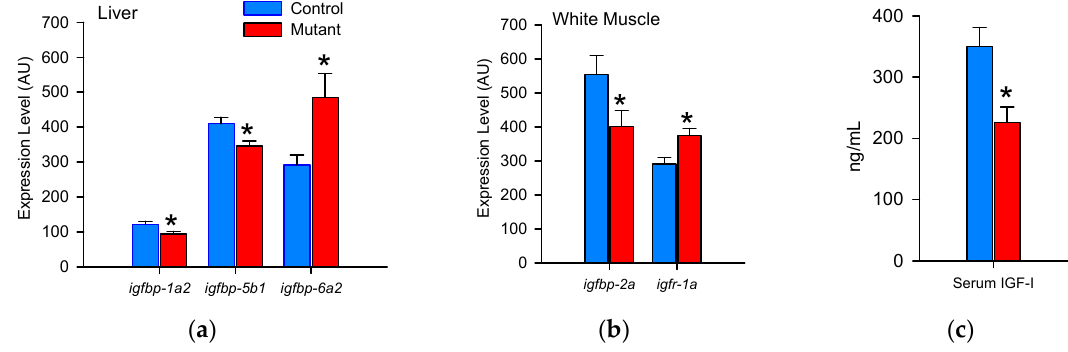
Figure 3. Differential regulation of somatotropic axis components. Panels indicate differentially regulated genes in ( a ) liver and ( b ) white muscle and ( c ) serum IGF-I in continuously fed control and mutant fish. Asterisks indicate significantly different means, p < 0.05 (gene expression: n = 21; plasma IGF-I: n = 8). AU: arbitrary units.